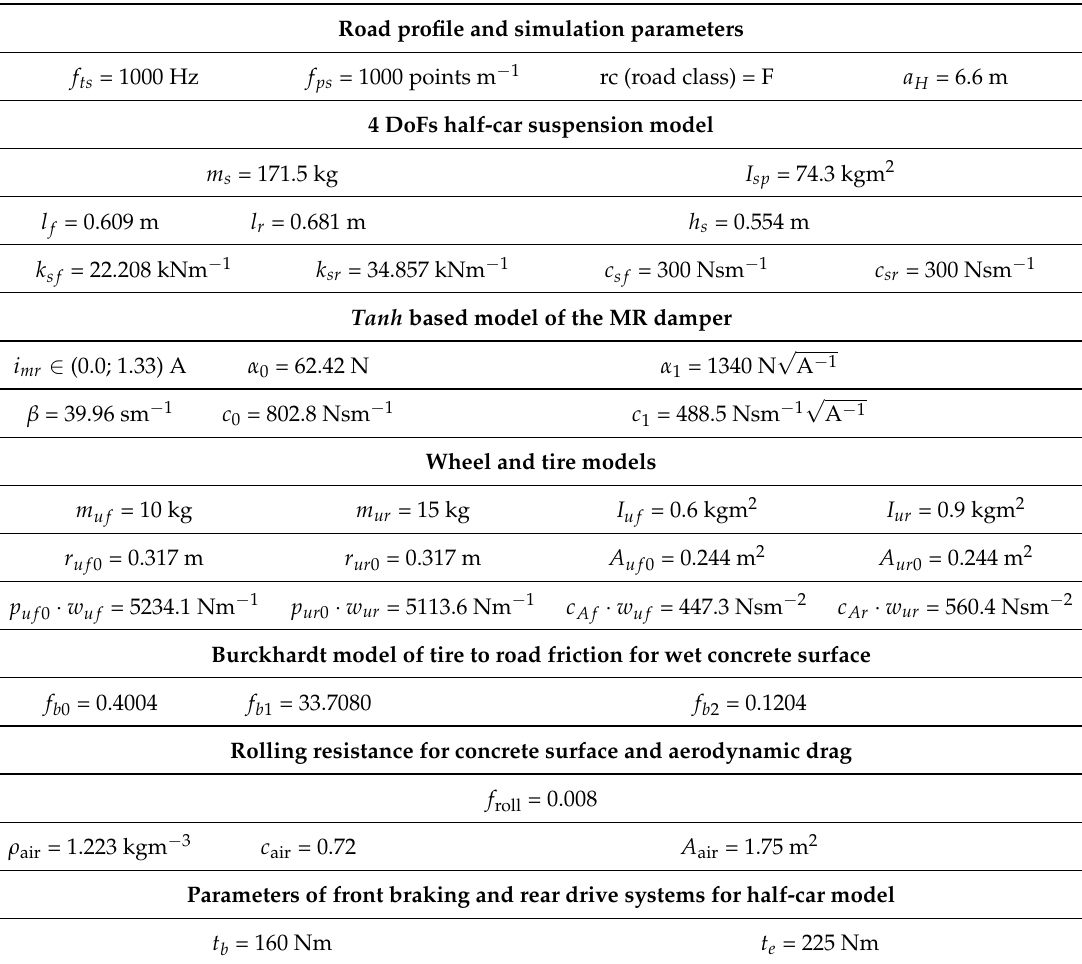
Table 1. Parameters of the vehicle model and its